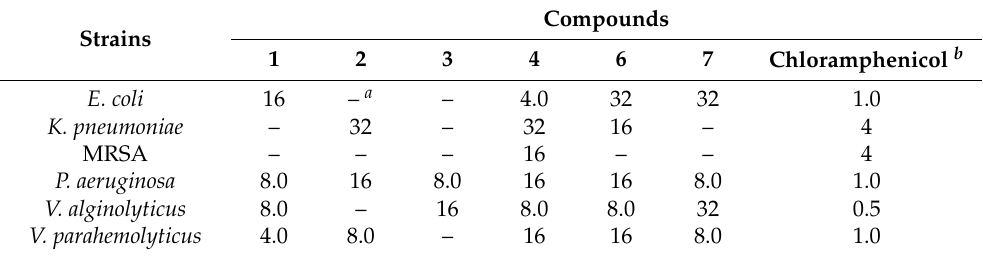
Figure 10. Experimental ECD spectrum of 6 (black line) compared with that calculated for (12 S ,13 S ,14 R ,15 R ) − isomer of 6 at BH&HLYP/TZVP level (red dashed line). Table 3. Antimicrobial Activities of Compounds 1 – 4 , 6 , and 7 (MIC, µ g/mL).